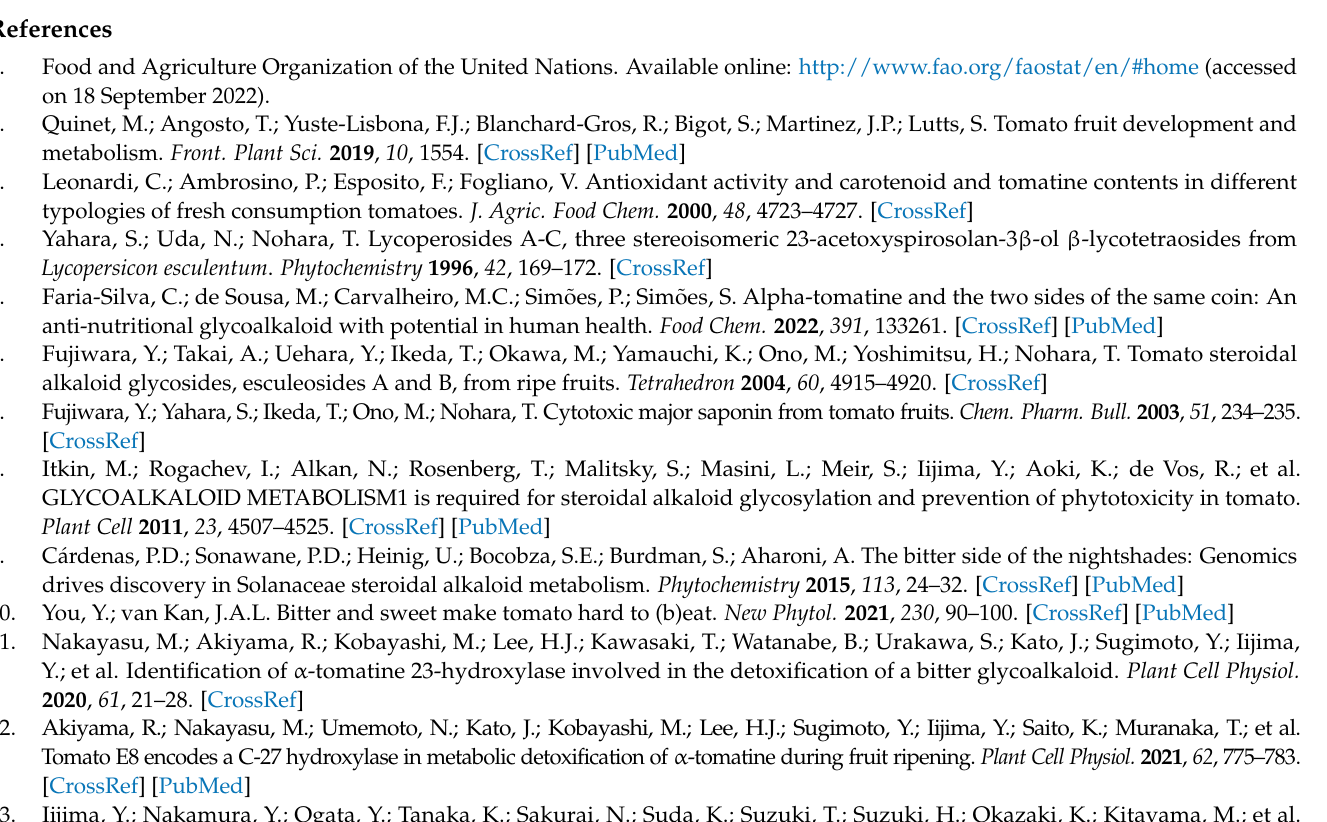
10.3390/plants11212895/s1, Figure S1: The screen for relative content of ( a ) tomatine ( (cid:4) ) in unripe fruits and ( b ) esculeoside A ( (cid:4) ) and tomatine ( (cid:4) ) in ripe fruits of the original cultivar of micro-tomato and its mutant lines, Figure S2: 1 H NMR spectrum of esculeoside A (600 MHz, pyridine- d 5 ), Figure S3: 13 C NMR spectrum of esculeoside A (150 MHz, pyridine- d 5 ), Table S1: Cell viabilities (%) of the Table S2: Cell viabilities (%) of the methanol extract of ripe red fruit of the micro-tomato original cultivar and mutant lines (n =